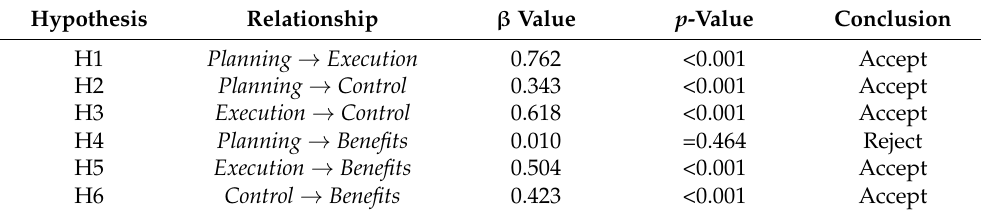
Table 6. Direct Table 6. Direct effects.